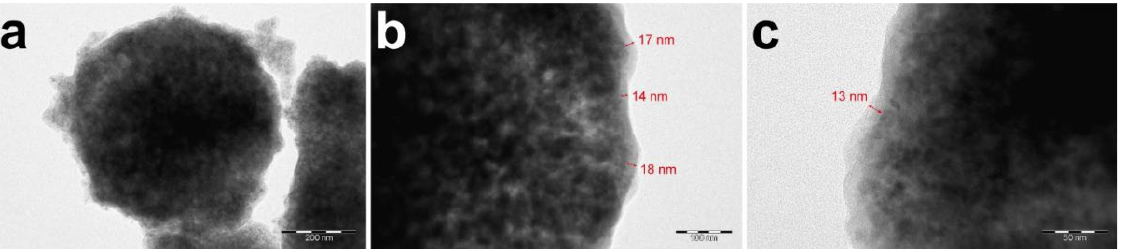
Figure 2. The TEM-images of CaCO 3 /MNP 3 /(BSA-Cy7/TA) 2 carriers core–shell structure at different magnifications, the scale bar corresponds to 200 nm ( a ), 100 nm ( b ), 50 nm ( c ).